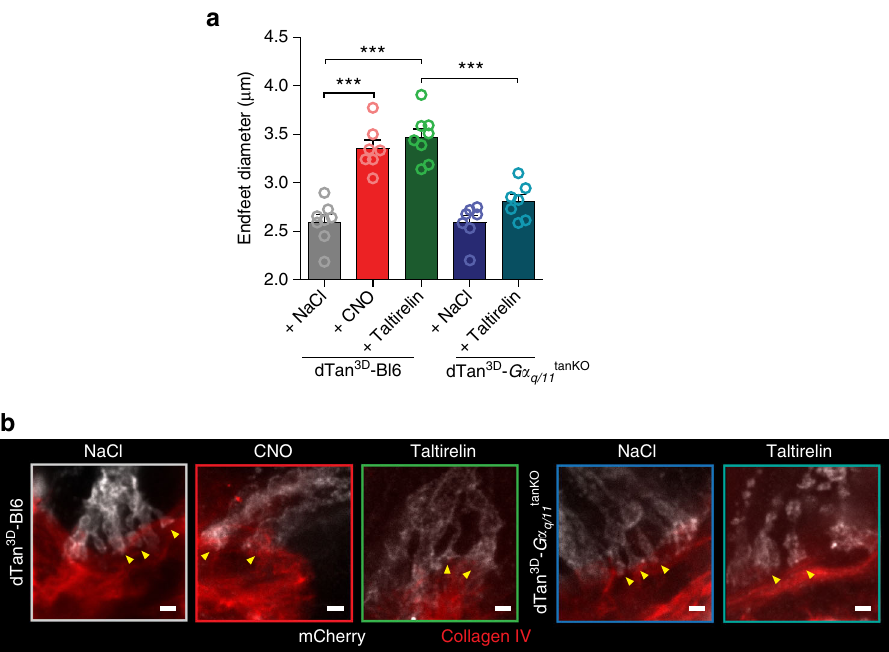
Fig. 5 Activation of the G α q/11 pathway induces changes in tanycytic endfoot diameters. a To express hM3D-mCherry in tanycytes, we injected AAV-CAG- fl ex(hM3D-mCherry) plus AAV-Dio2-iCre-2A-GFP in the LV of C57Bl/6 (dTan 3D -Bl6) or G α particles of each vector in a total volume of 2.5 µ l). One hour after treating mice with 0.9% NaCl (dTan 3D -Bl6, n = 8; dTan 3D - G α q/11 tanKO , n = 7), CNO ( n = 7) or taltirelin (dTan 3D -Bl6, n = 8; dTan 3D - G α q/11 tanKO , n = 7), the diameters of 18 – 26 tanycytic endfeet were quanti fi ed. Mean diameters per animal are presented. One-way ANOVA, F(4/32) = 29.47, p < 0.0001; *** p < 0.0001 between indicated groups (Bonferroni post test); mean ± S.E.M. b Representative images of tanycytic endfoot morphology ( yellow arrowheads ) for all groups (mCherry, gray ; collagen IV, red ). Scale bar , 2 µ